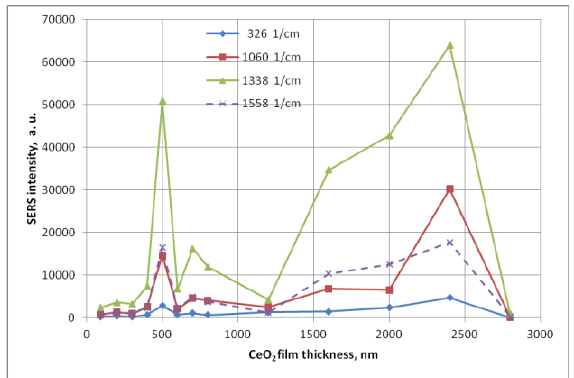
Figure 6: SERS signal at different Raman scattering bands from DTNB - Au-NP on cerium dioxide films with various thicknesses after normalization to the amount of gold nanoparticles.